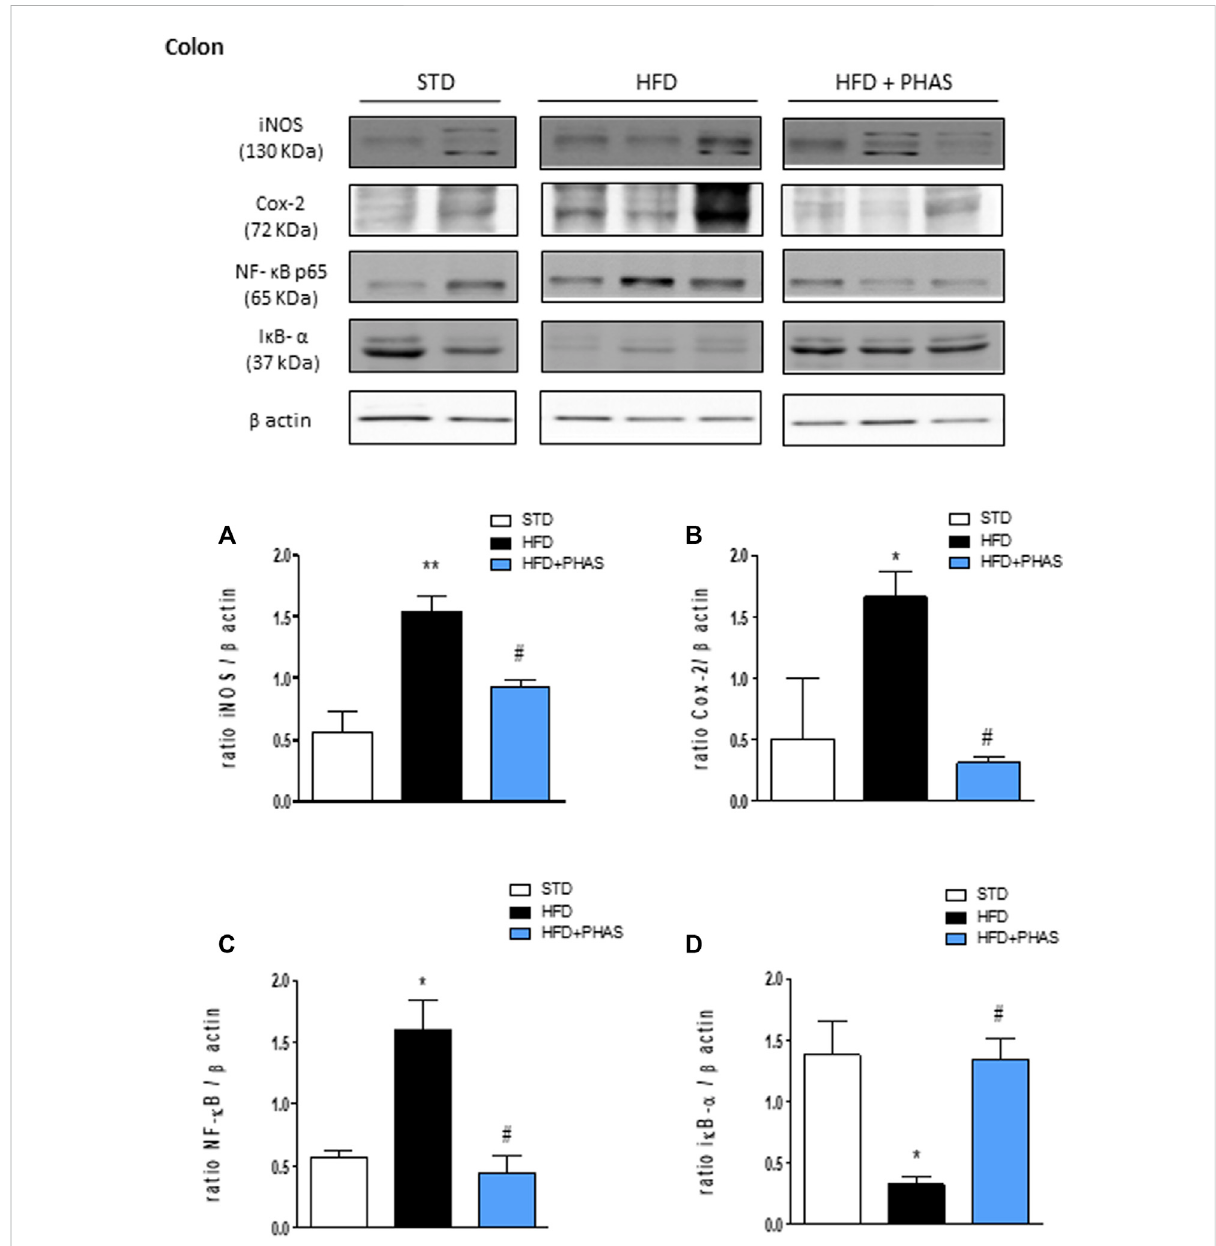
FIGURE 6 Anti-in fl ammatory effect of P. vulgaris extract (500 mg/kg, PHAS 500) measured using pro-in fl ammatory markers in thecolon inHFD mice: (A) iNOS; (B) COX-2; (C) NF- κ B; and (D) I κ B- α expression levels are reported as the ratio of optical densities of their bands to β -actin. Immunoblot representatives were shown. Densitometric evaluations of protein levels were reported. Data are expressed as means ± SEM ( n = 6). * p < 0.05 and ** p < 0.01 vs. STD; # p < 0.05 vs.